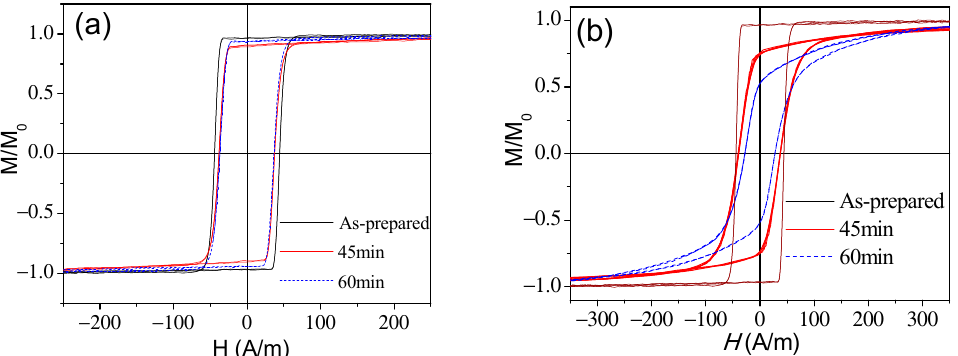
Figure 16. Hysteresis loops of as-prepared and annealed at T ann = 325 °C ( a ) and as-prepared and stress-annealed at T ann = 325 °C and σ m = 190 MPa ( b ) Fe 75 B 9 Si 12 C 4 microwire. Adapted from [98].